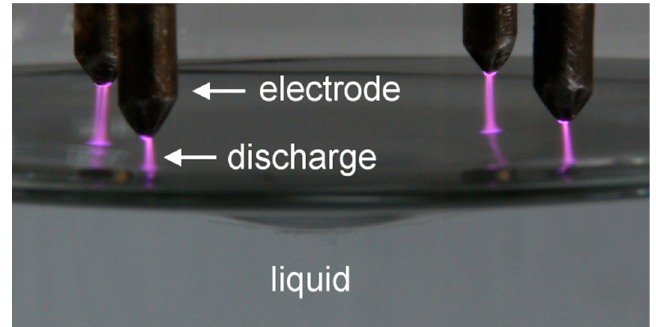
Figure 2. Photograph of the 4-electrode configuration for treatment of up to 1 L water [28].